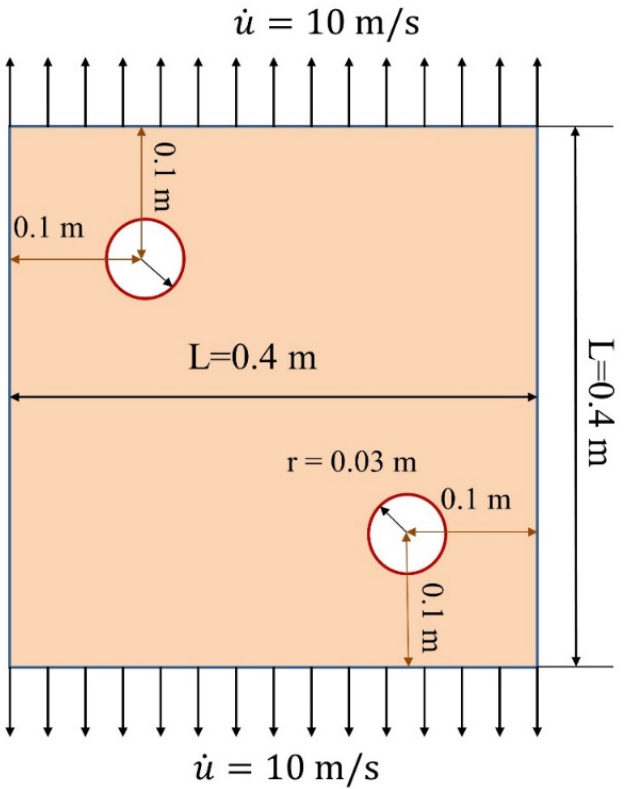
Figure 10. Schematic diagram of a tensile test of a plate specimen.